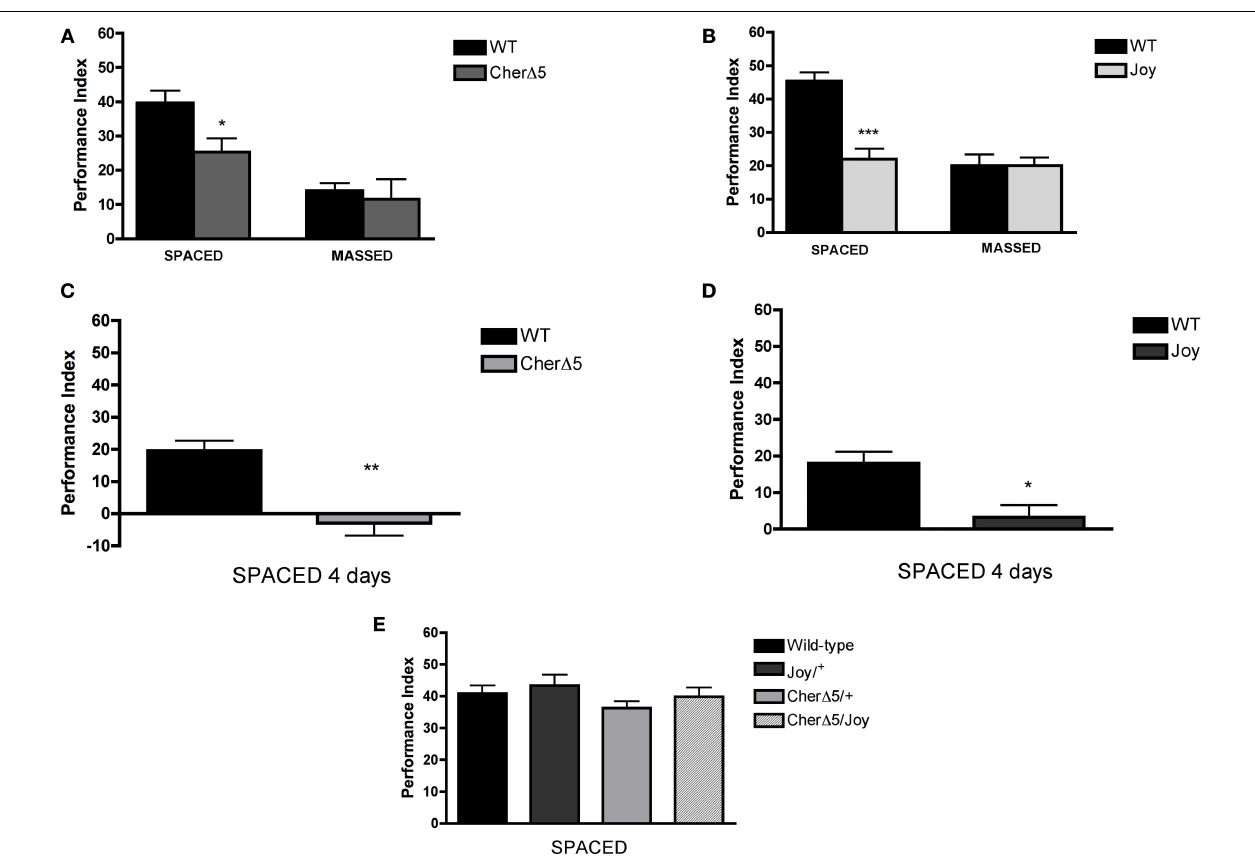
( P = 0.4149; N = 8 PIs per genotype). (C) 4-day memory after spaced training is lower than normal in the cher Δ 5 (Cher Δ 5 ) mutant ( P = 0.0034; N = 4 PIs